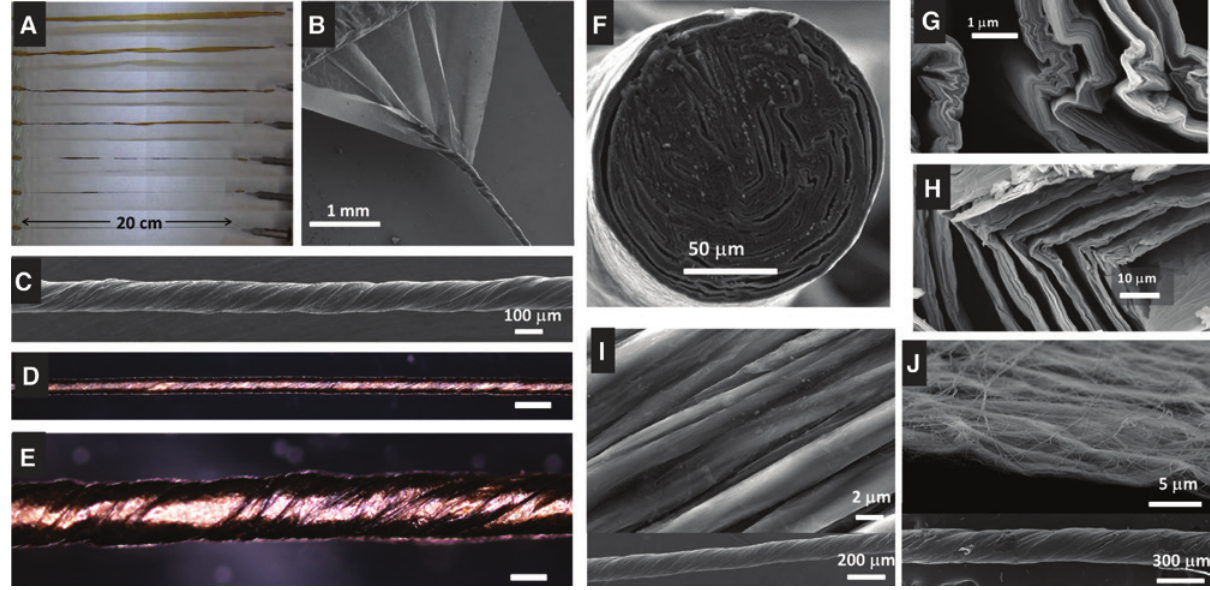
Figure 4: GO fibers prepared by scrolling GO films. (A) Snapshots of the scrolling process. (B) SEM showing a detail of the scrolling area. (C) SEM image of a typical scrolled GO fiber. (D) Optical microscopy image of a GO fiber made with very a thin film (approximately 700 nm). (E) GO fiber produced with a thicker film (2.9 μ m thick). (F) SEM image of a cross section of a GO film made by scrolling after being cut using a focused ion beam. (G) Folding behavior of the 700-nm and (H) 2.9- μ m-thick GO films. (I) and (J) show nanocomposite films (top) and fibers (bottom) made with tungsten disulfide and polymer nanofibers,